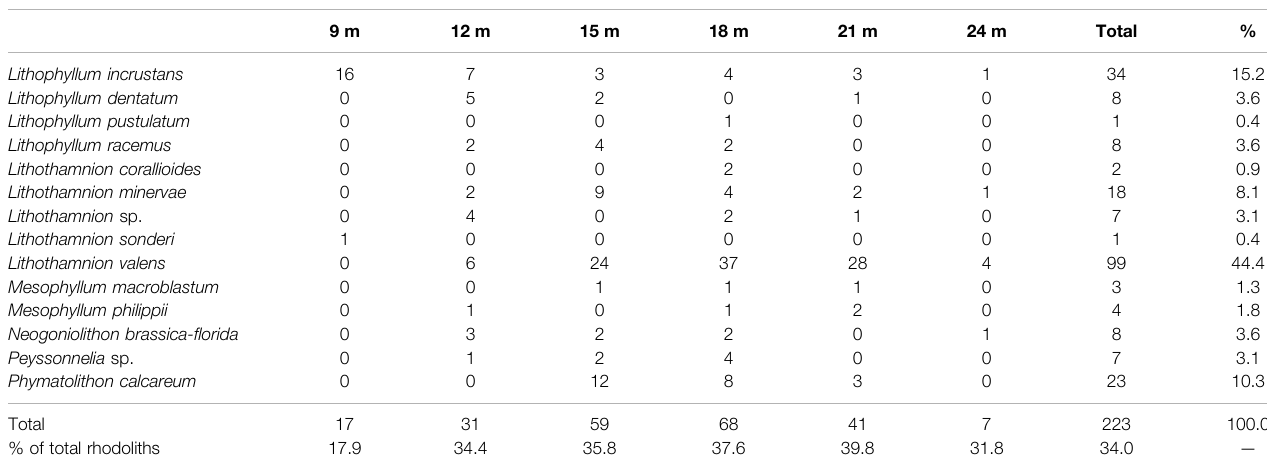
TABLE 2 | Counts of monospeci fi c rhodoliths by